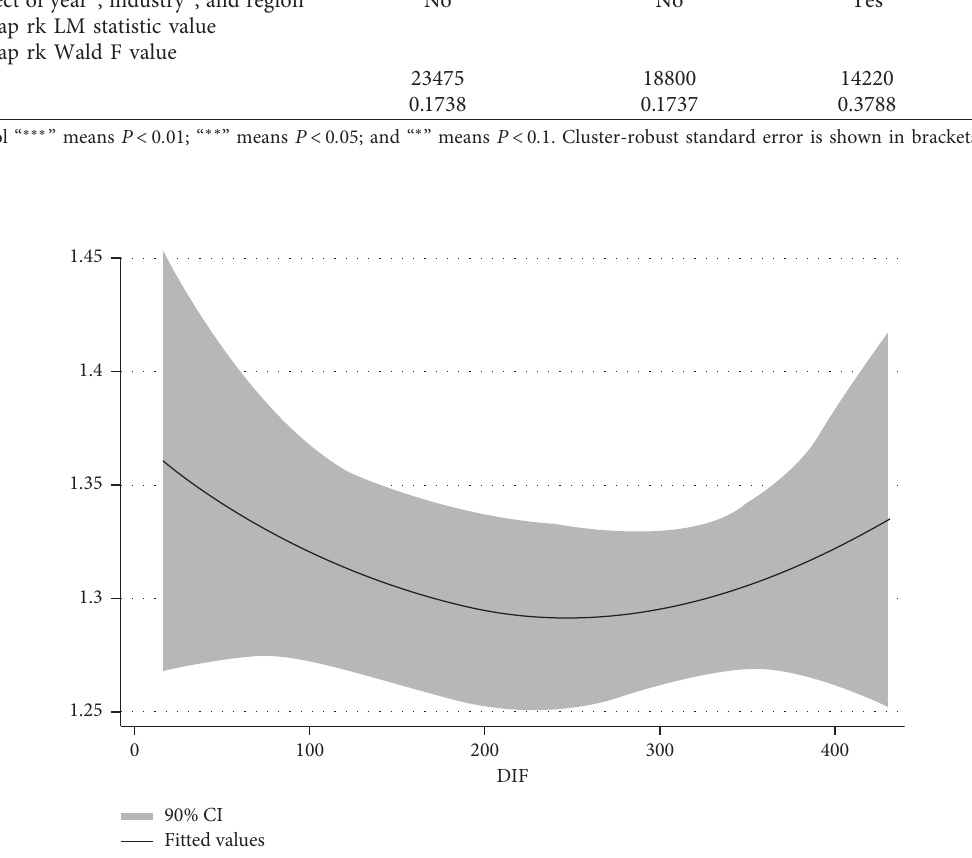
Figure 1: Quadratic curve fit of digital finance and financial